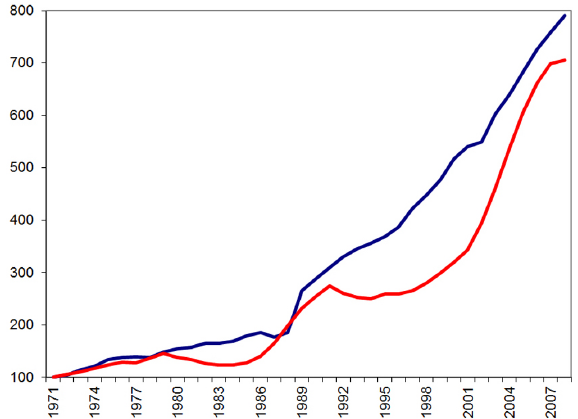
Fig. 2. Surcharges (premiums) paid to the Consorcio de Compen- saci´on de Seguros (in blue) and value of dwellings (in red) in Spain 1971–2008 adjusted for inflation to 2008 (index 1971 = 100).